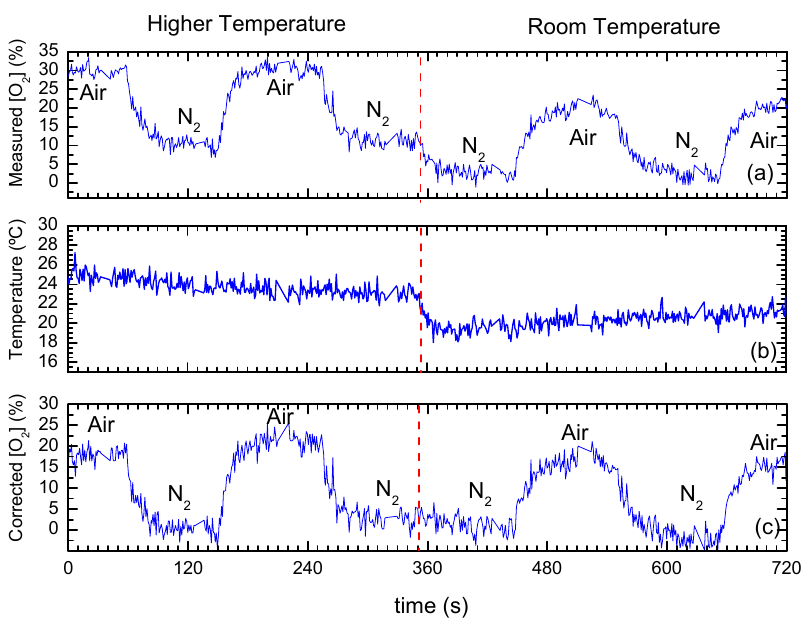
Figure 10. Sensor output when subjected to simultaneous change of oxygen and temperature: (a) O measured by Ru(dpp); (b) temperature measured by QD; (b) temperature compensated O